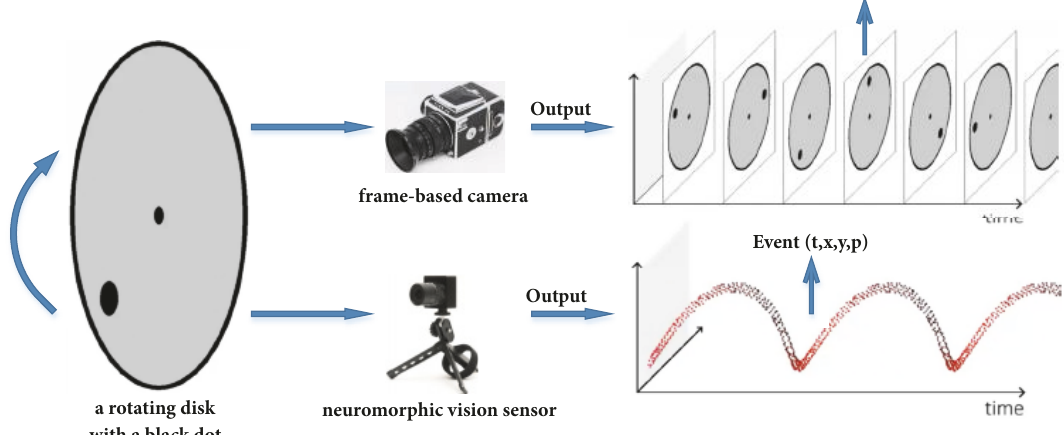
Figure 1: Visualization of the output from a neuromorphic vision sensor and a standard frame-based camera when facing a rotating disk with a black dot. Comparing to conventional frame-based camera which transmitted complete images at fixed latency, the neuromorphic vision sensor [1] emitted events individually and asynchronously at the time they occur. This figure is adopted from